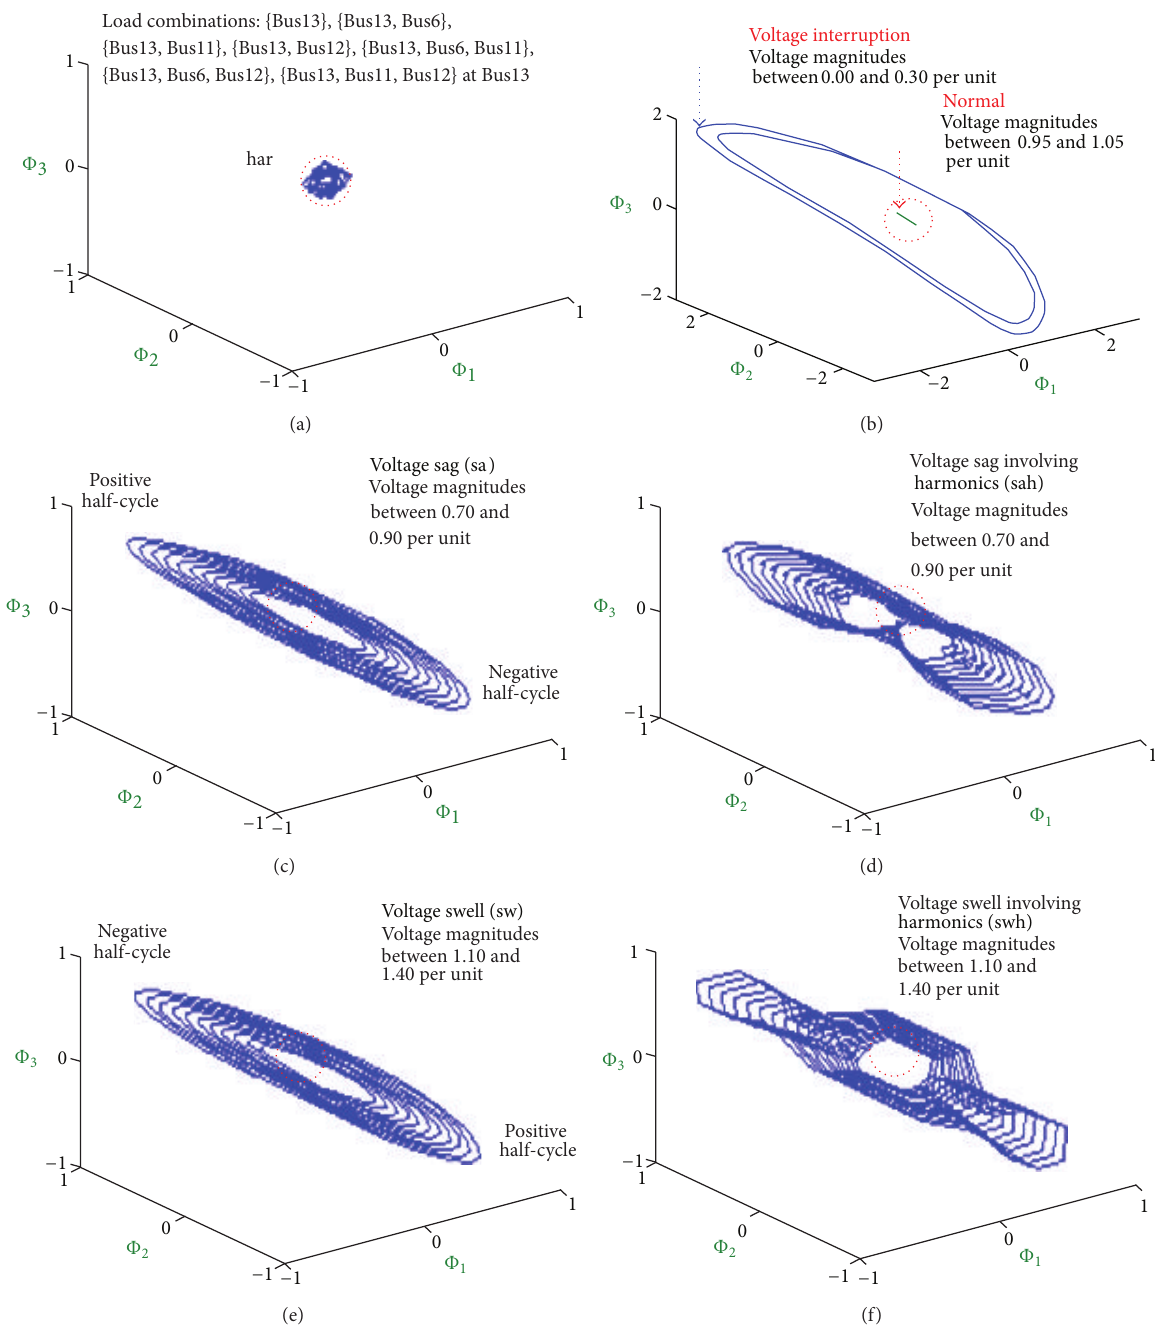
Figure 5: Various butterfly patterns at Bus13. (a) Butterfly patterns for harmonics, (b) butterfly patterns for normal voltage and voltage interruption, (c) and (d) butterfly patterns for sag events, and (e) and (f) butterfly patterns for swell